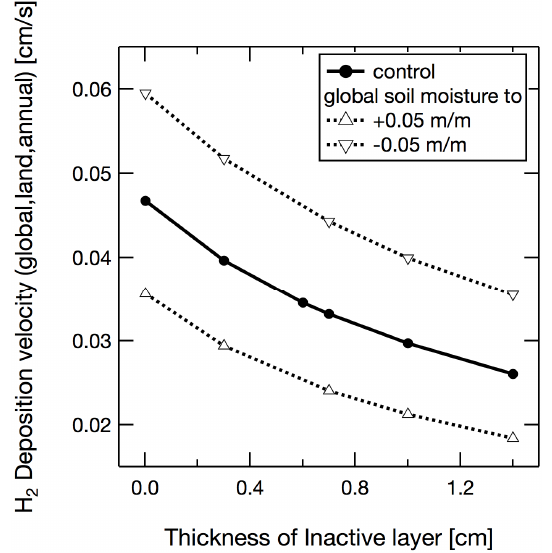
Fig. 10. The sensitivity experiments on the change in the global av- Fig. 10 The sensitivity experiments on the change in the global averaged H 2 eraged H 2 deposition velocity on land as a function of the thickness of the inactive deposition velocity on land as a function of the thickness of the inactive layer.